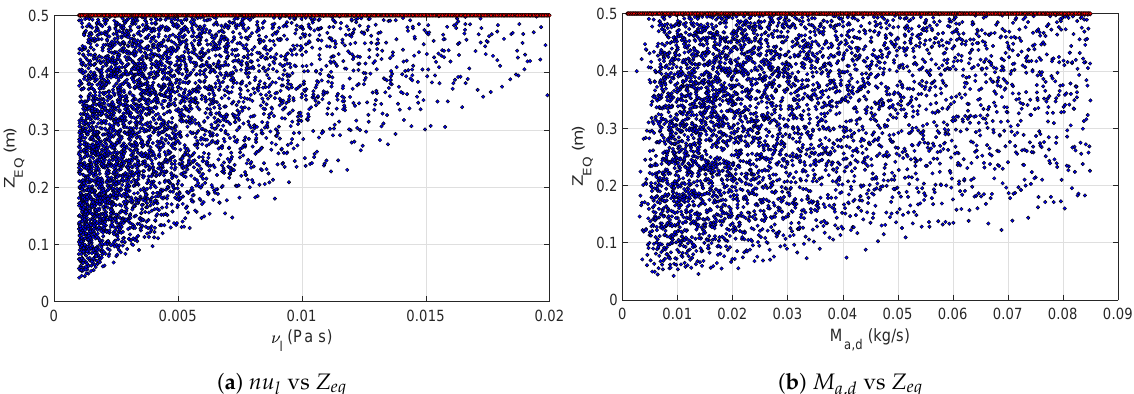
Figure 11. Scatter plots of equilibrium length Z eq with respect to the feed viscosity ν l ( a ) and mass flow rate of the drying air M a , d ( b ). The red dots indicate the values at non-equilibrium conditions, while blue dots represent the values at